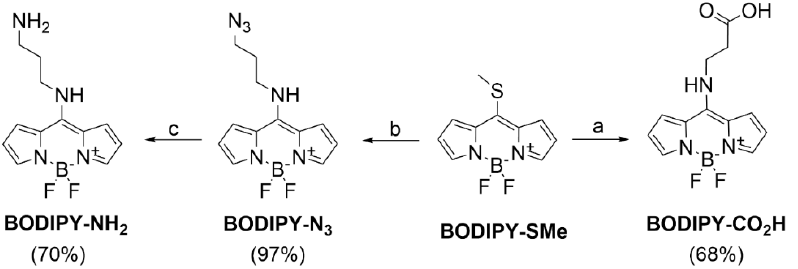
Figure 2. Synthesis of functionalized BODIPY dyes. Reagents and conditions: ( a ) β -Ala, DMSO-H 2 O, 30 °C, 12 h; ( b ) 3-azidopropylamine, DCM, 30 min, RT; ( c ) H 2 , Pd/C, AcOEt, 2h, RT.